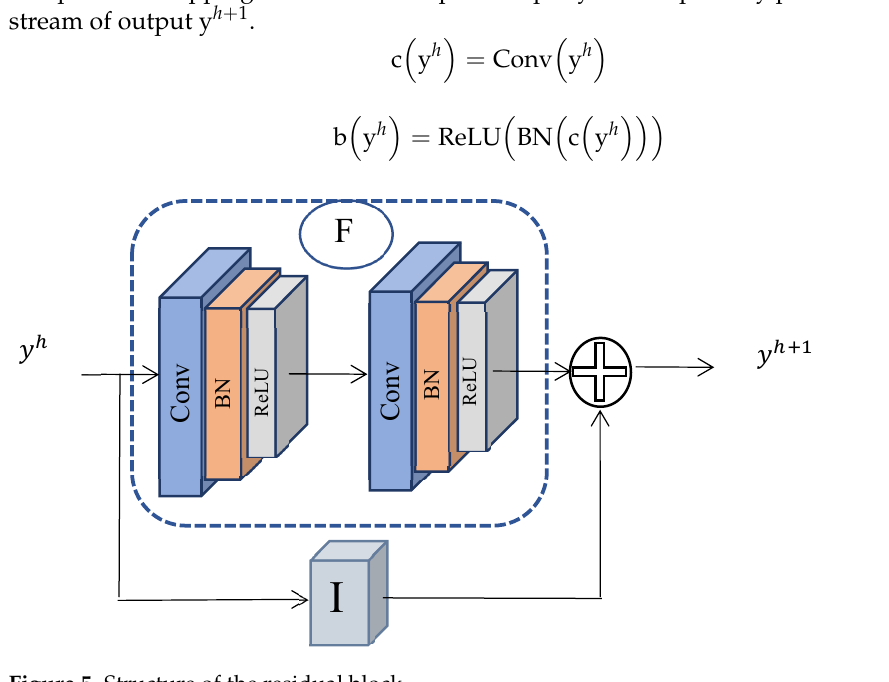
Figure 5 . Structure of the residual block. Figure 5. Structure of the residual